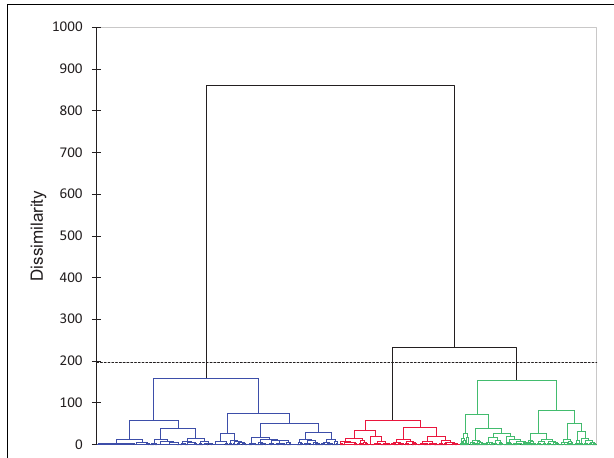
FIGURE 3 | Dendrogram of the classes.